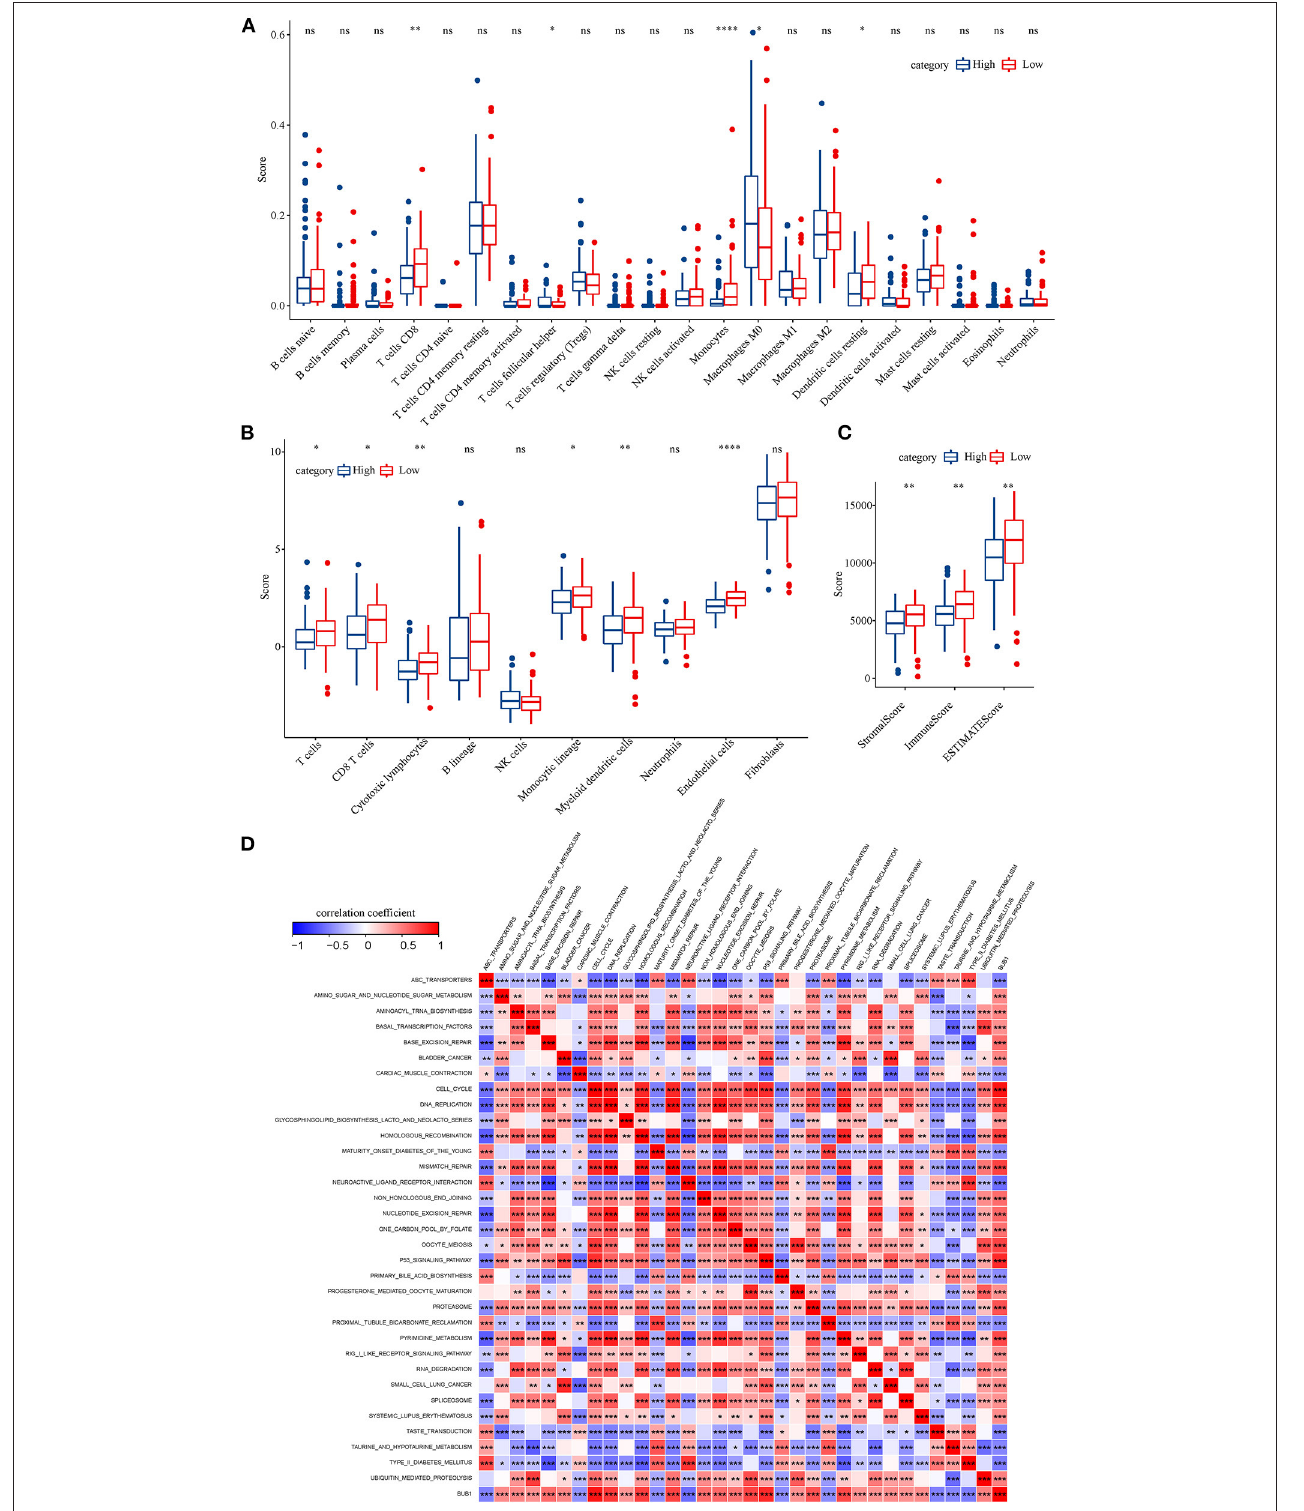
FIGURE 11 | BUB1 expression and immune and functional analysis. (A) Distribution difference of 22 kinds of immune cell infiltration in patients with high and low expression of BUB1. (B) Distribution difference of immune cell infiltration in 10 kinds of patients with high and low expression of BUB1. (C) Differences in the distribution of immune infiltration in patients with high and low expression of BUB1. (D) BUB1 expression was significantly related to KEGG pathway.